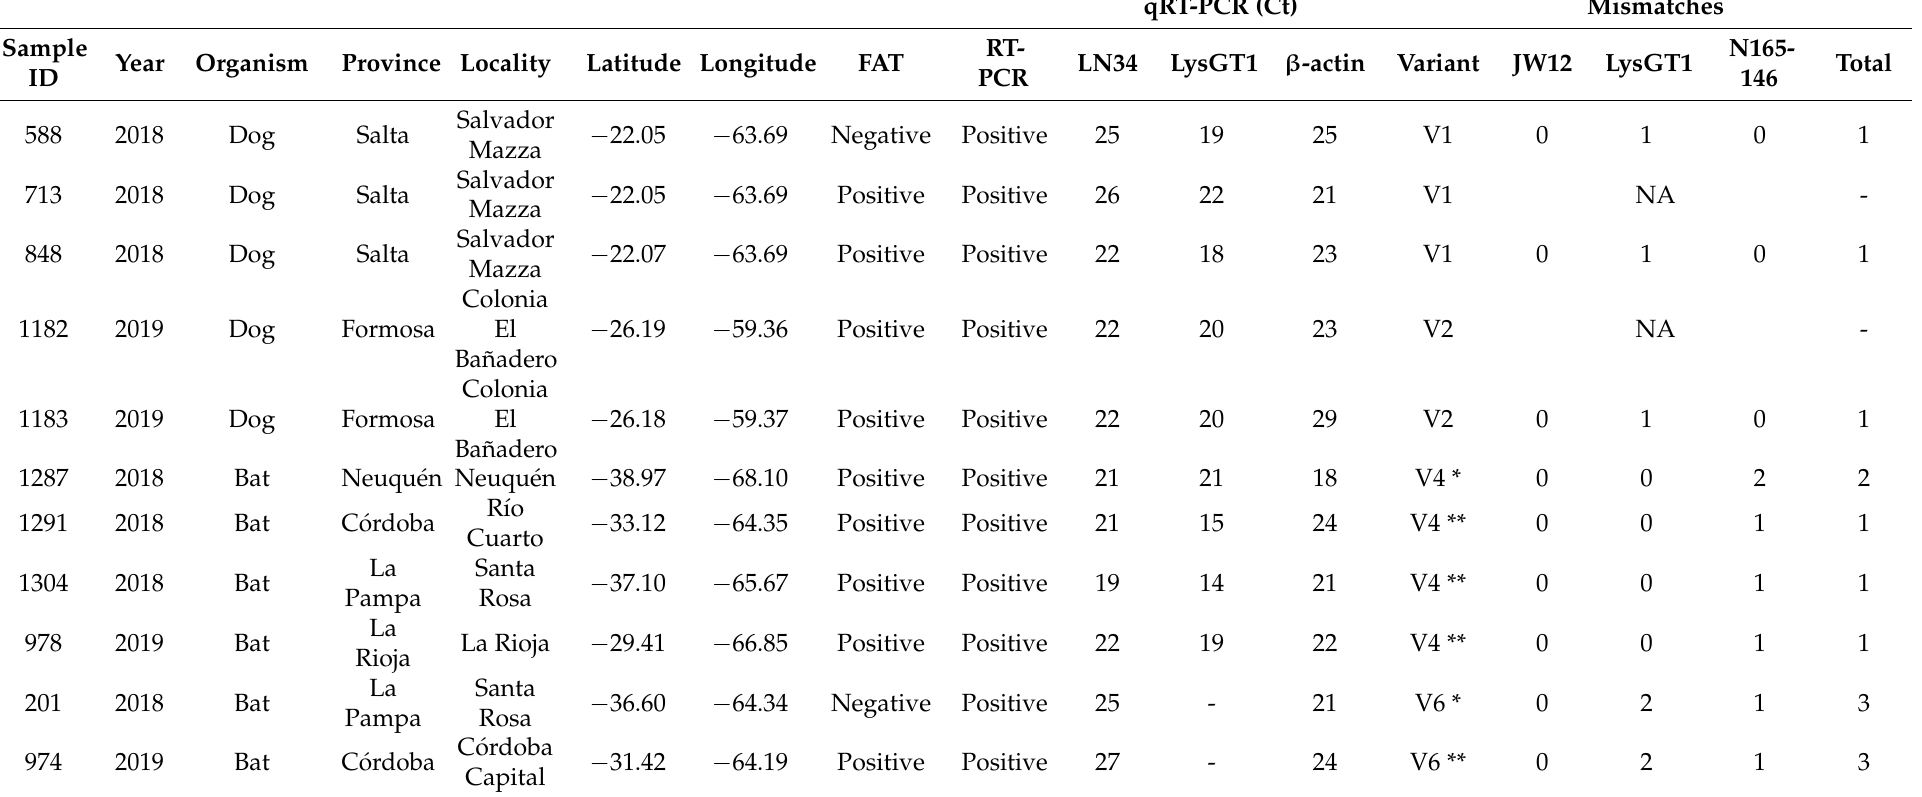
Table 2. Samples characterized as V1, V2, V4, V6, Myotis, Eptesicus, and Histiotus, analyzed in this study. Source, year of submission, place of origin, Direct Fluorescent Antibody Test (FAT), RT-PCR, and qRT-PCR results are shown. The number of asterisks indicates the denomination of each sequence in Figure 3. The number of mismatches in the primers/probe region of the LysGT1 oligos is shown